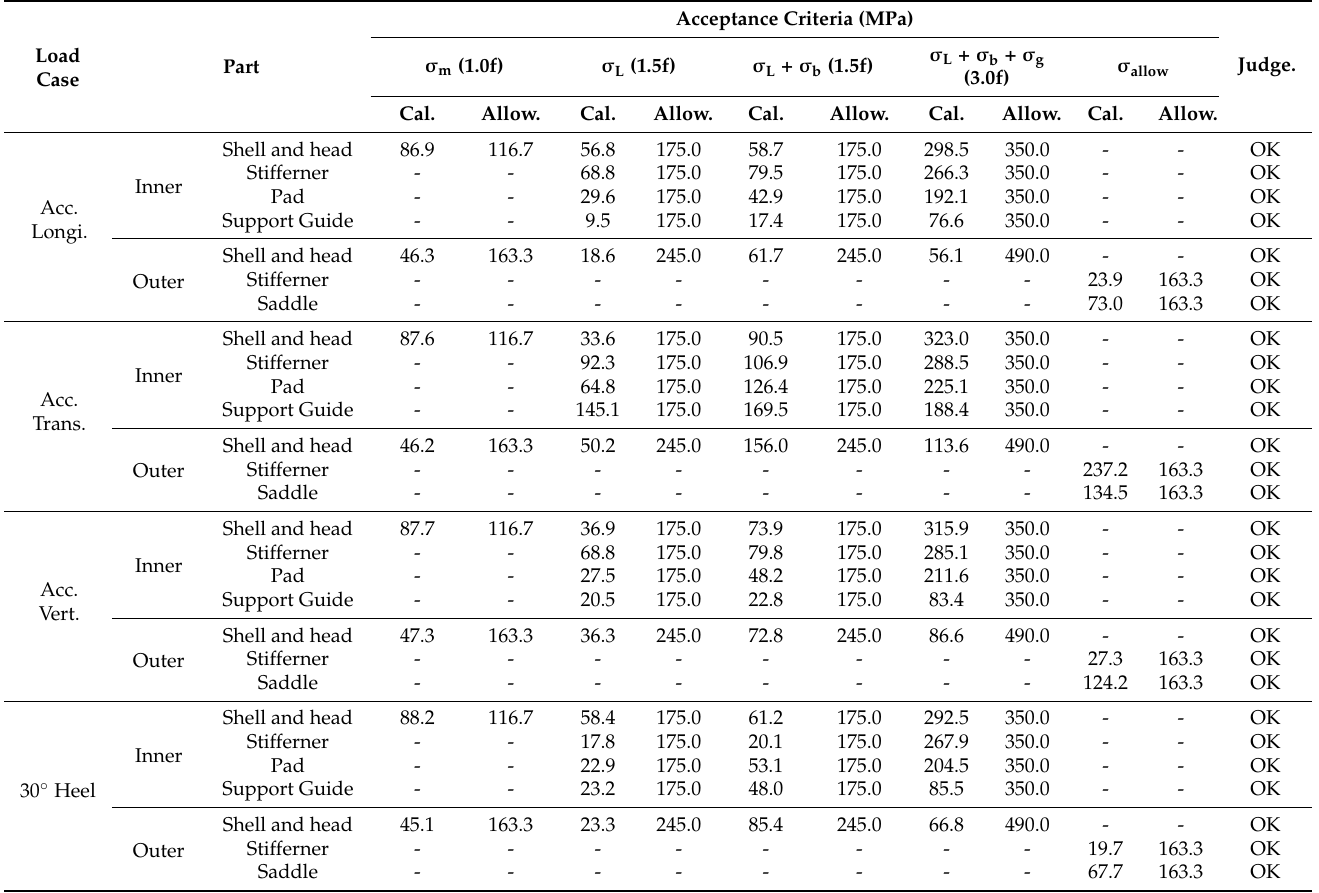
Table A2. Summary of structural analysis result for